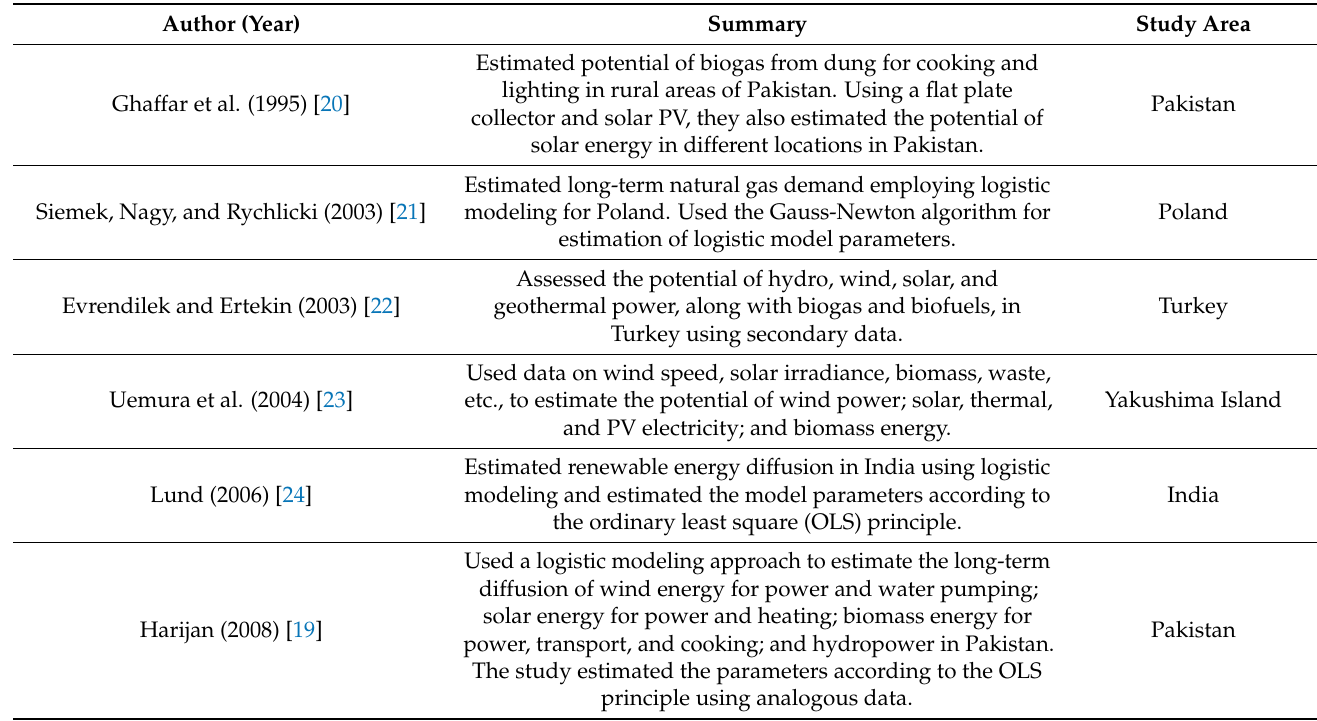
Figure 11. Hydropower map of Pakistan [19]. Table 4. Summary of the assessment of renewable-energy-related